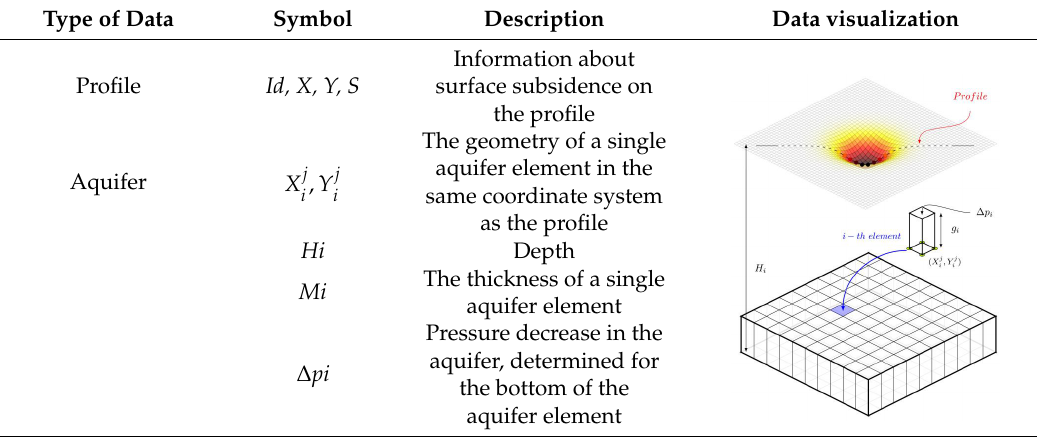
Table 1. Required input data for the SubCom v1.0 program.